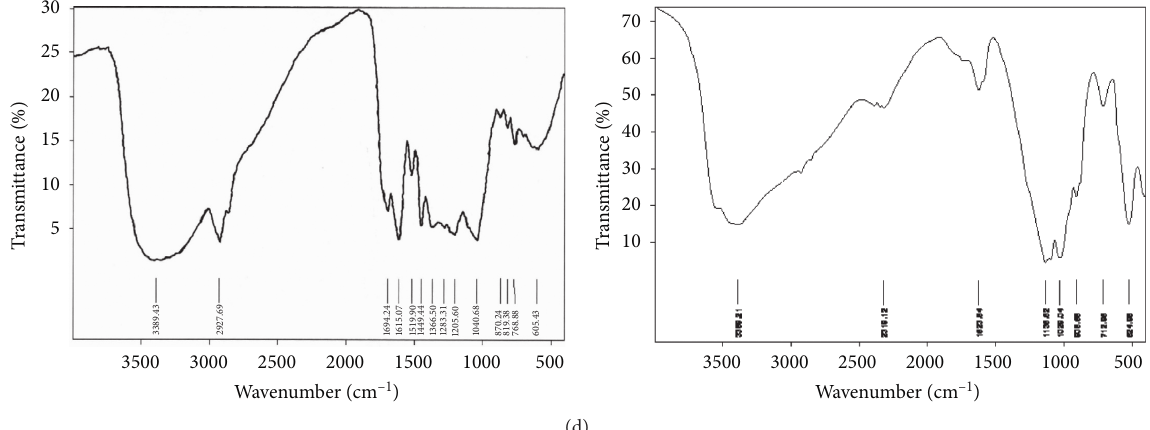
Figure 1: FTIR spectra of methanolic plant extract.